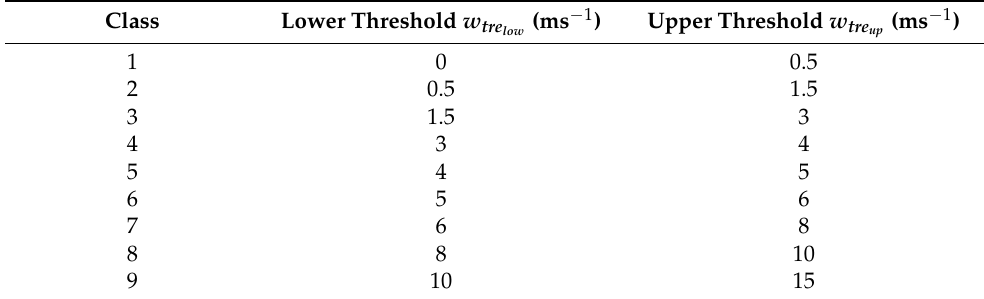
Table 3. Classification of available data with respect to nine different wind speed thresholds with w avg ∈ [ w tre , w tre up low